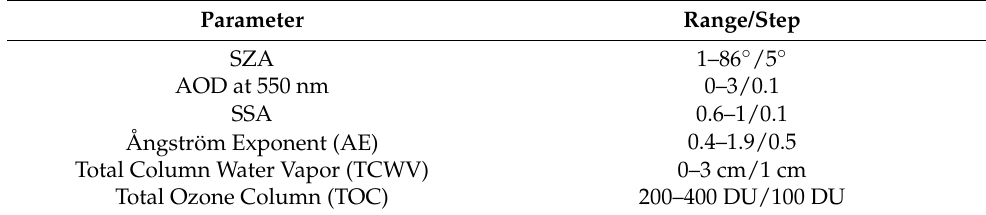
Table 1. Input parameters for